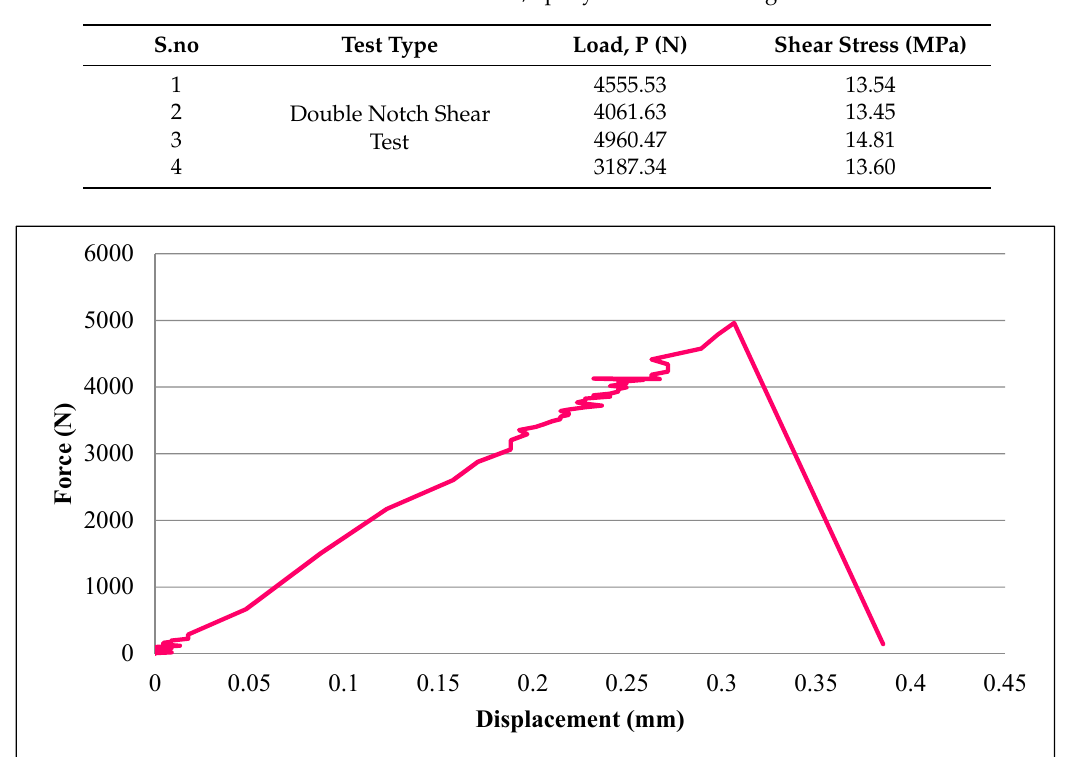
Table 6. Aluminum-carbon fiber/epoxy bond shear strength results.